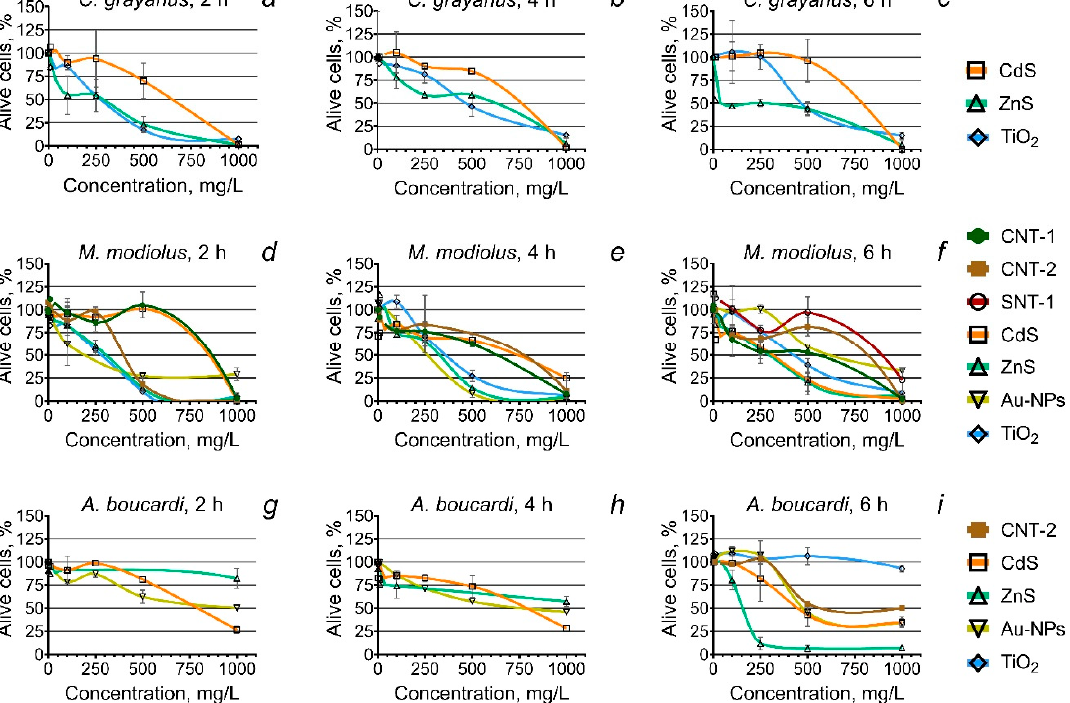
Figure 1. The viability of hemocyte cells of the molluscs C. grayanus , M. modiolus , and A. boucardi after the treatment with the nanoparticles (NPs); ( a–c ) the changes in the total number of alive C. grayanus hemocytes after 2, 4, and 6 h exposure to the NPs, respectively; ( d–f ) the changes in the total number of alive M. modiolus hemocytes after 2, 4, and 6 h exposure to the NPs, respectively; and ( g–i ) the changes in the total number of alive A. boucardi hemocytes after 2, 4, and 6 h exposure to the NPs, respectively. CNT, carbon nanotube; SNT, silicon nanotube.